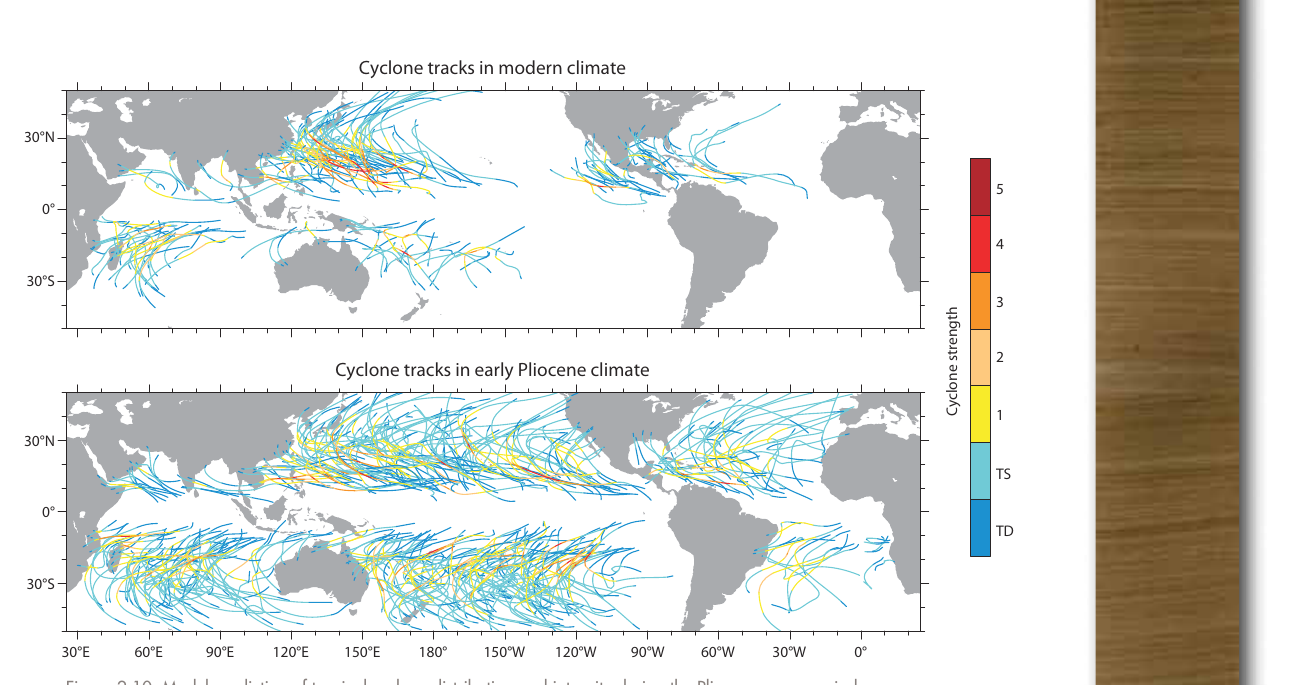
figure 2.10. model prediction of tropical cyclone distribution and intensity during the pliocene warm period (representing ~4 million years ago) showing a dramatic increase in the number and geographic extent of tropical cyclones in a slightly warmer world. The colors indicate hurricane strength—from tropical depression (Td, blue), to tropical storm (Ts, teal), to category-5 cyclones (red). The pliocene model simulation used reduced meridional and zonal tropical sea surface temperature gradients as reconstructed using deep-sea sediments (e.g., figure 2.9; see fedorov et al., 2010).